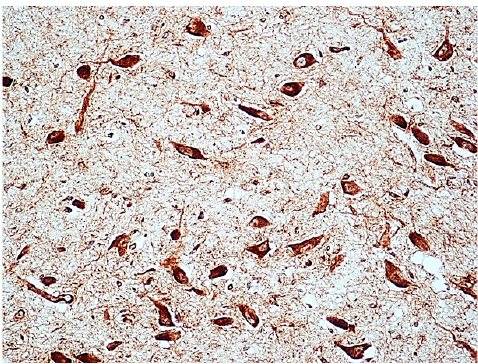
Figure 3. Strong α 7-nAChR immunopositivity (“Class 3” of α 7-nAChR-Index) in the pontine facial/parafacial complex with normal cytoarchitecture in an SIUD case (38 gestational weeks). α 7-nAChR immunostaining; magnification: 40×.